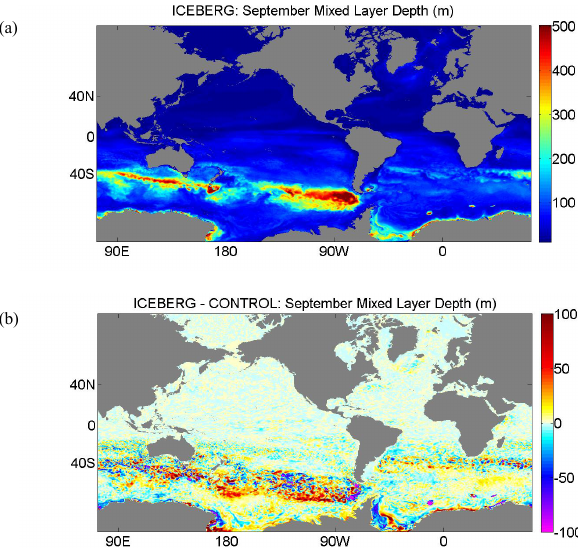
Figure 12. Mixed layer depth in September (year 26–30 average): (a) ICEBERG; (b) ICEBERG minus CONTROL.